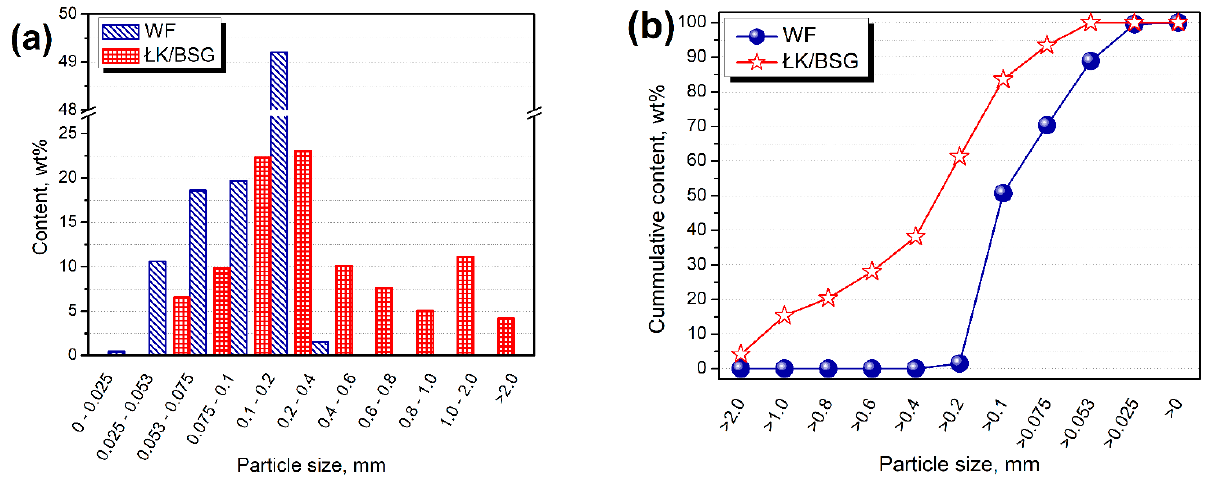
Figure 2. Plots of ( a ) particle size distribution and ( b ) cumulative particle size distribution of applied fillers.